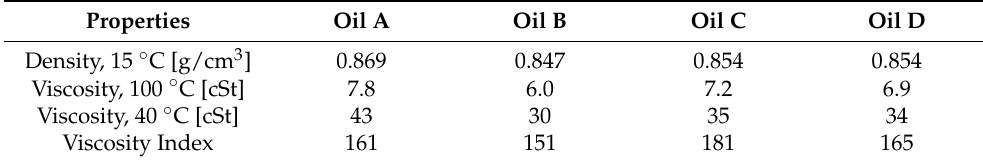
Table 2. Properties of the ATFs.